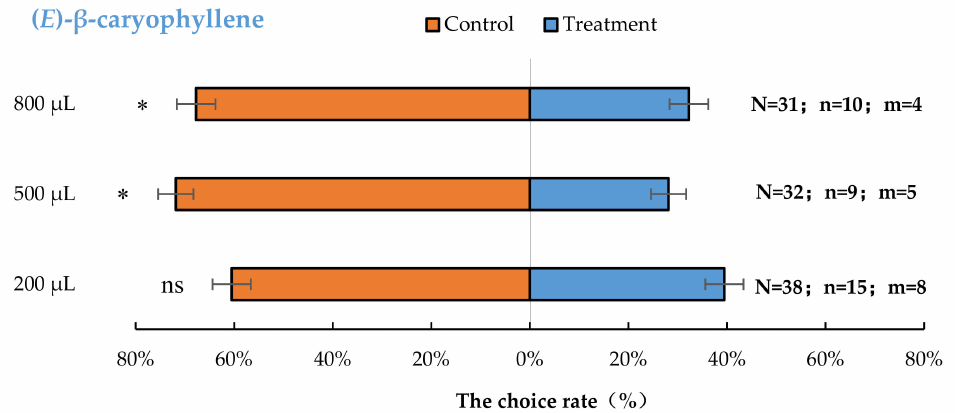
Figure 5. Behavioural responses of A. bungii females to different quantities of ( E )- β -caryophyllene. Note: N = number of responsive A. bungii ; n = number of A. bungii females choosing the treatment; m = number of A. bungii that made no choice. ns = no significant difference; * = significant difference at the 0.05